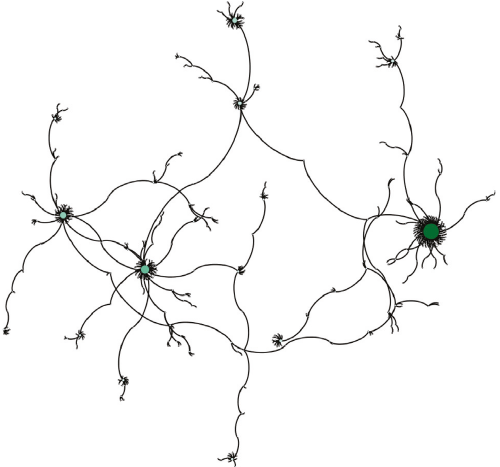
Figure 3: For replying interactions, new links between nodes from March 12 until April 12 in